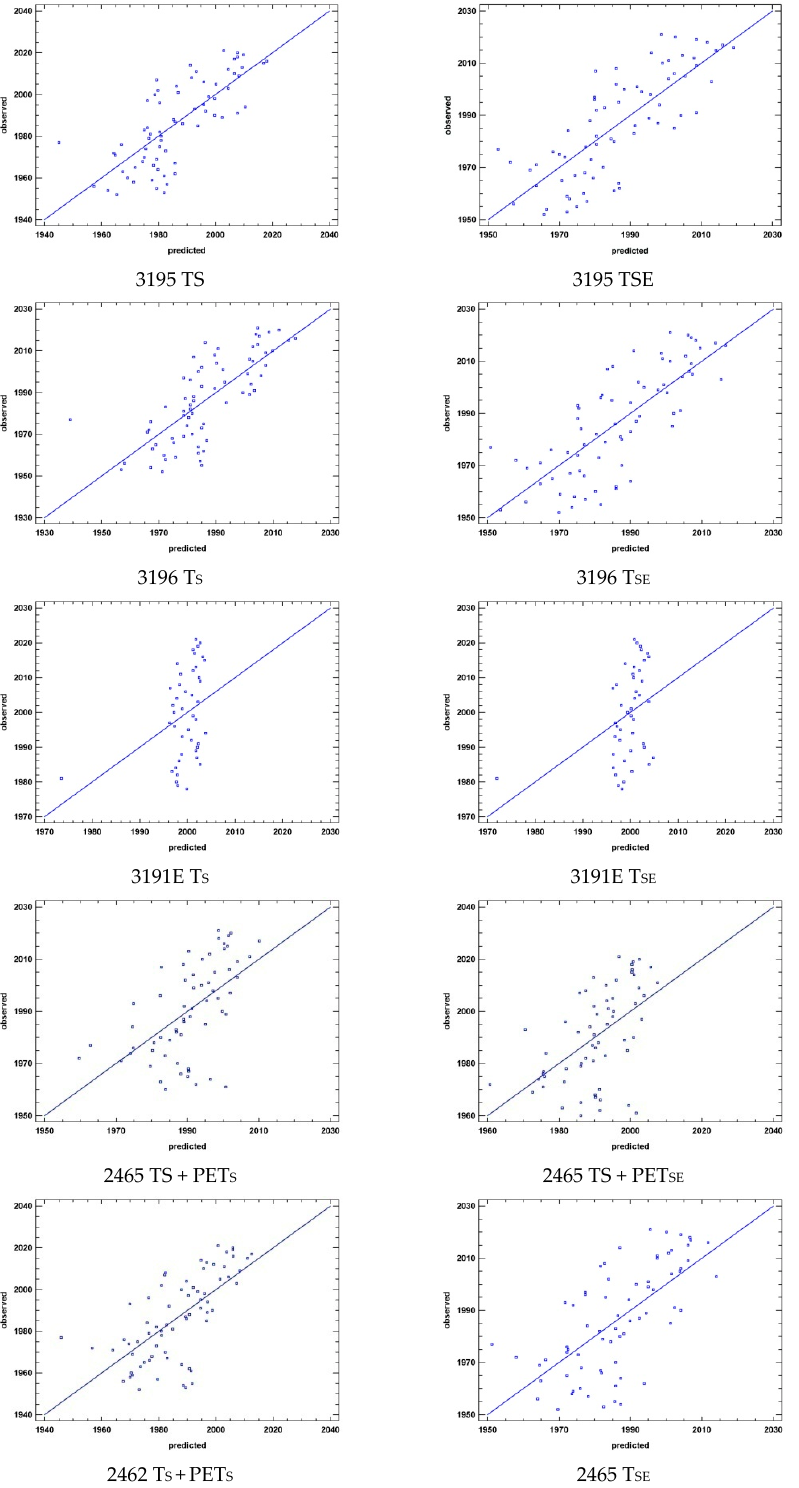
Figure 2. Multiple regression results. Meteorological station codes in Table 1; studied parameter abbreviations in Table 2.